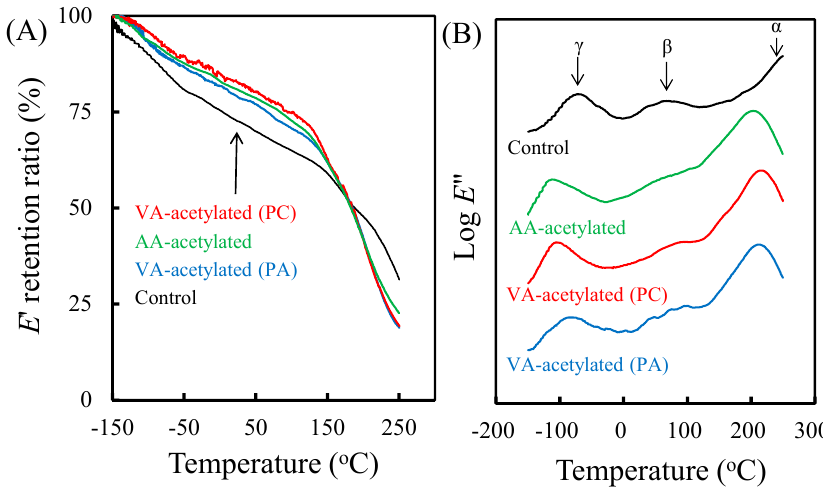
Figure 5. The storage modulus ( E ′ ) retention ratio ( A ) and loss modulus ( E ″ ) ( B ) of unmodified slicewood, AA-acetylated slicewood (WPG 21%), and VA-acetylated slicewood (cWPG 18%) with PC and PA.